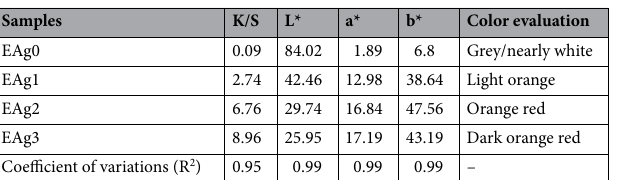
Table 4. Colorimetric data for control and nanosilver-coated sisal/cotton interwoven fabrics.